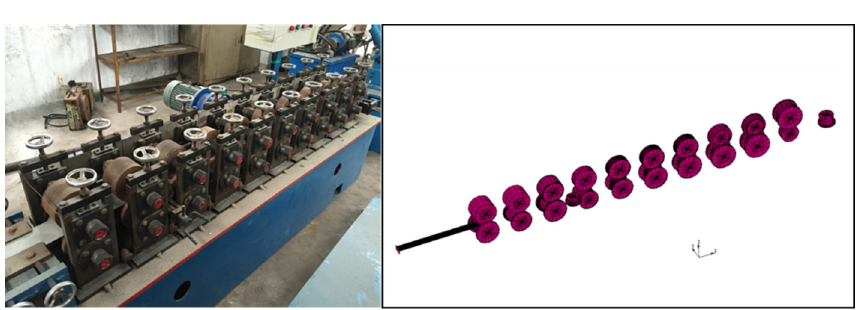
Table 2. Mechanical properties of Q235 steel.